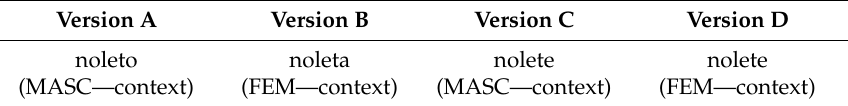
Table 2. Examples of forms built with the same root in the four